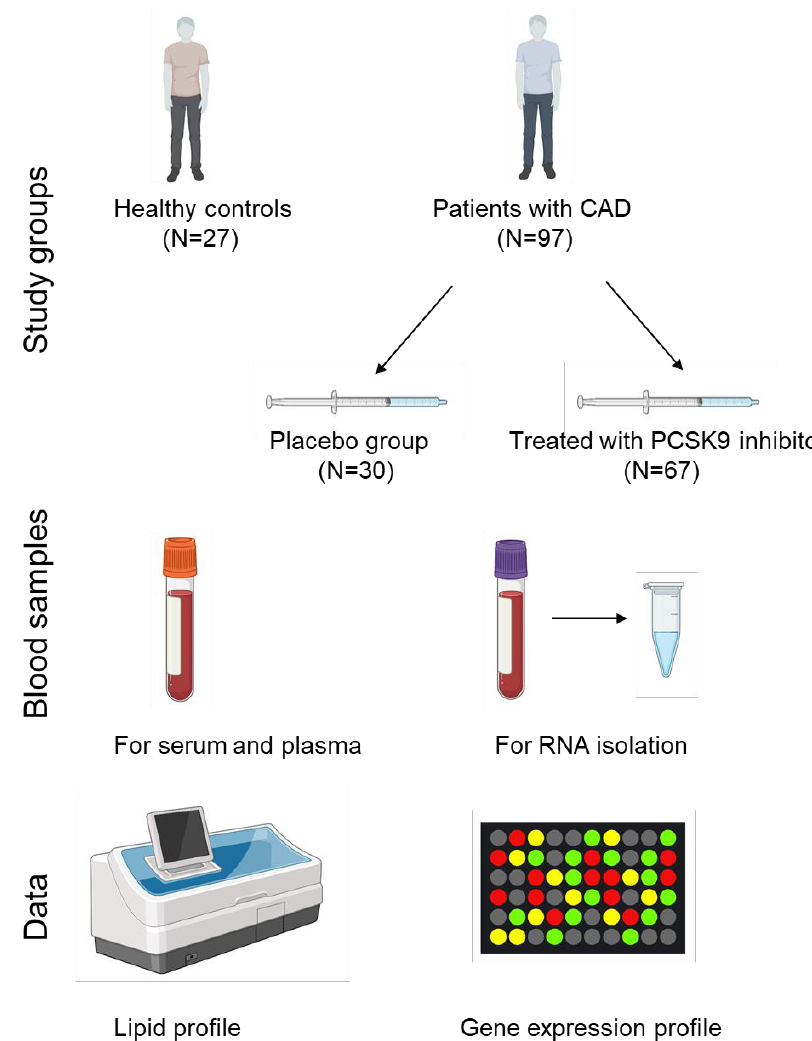
Figure 1. The study design. Subjects included in the study were healthy adults with no history of CAD and patients with CAD. Patients with CAD were randomized to the placebo group and the group treated with PCSK9 inhibitors, i.e., alirocumab (150 mg, N = 34 patients) or evolocumab (140 mg, N = 33 patients) for six months. Blood samples were taken at a single point for healthy controls and at the baseline and after six months of treatment for CAD patients. The lipid profile was measured and gene expression for the five studied genes ( IL1B , IFNG , VEGFA , F3 , SERPINE ), and two reference genes ( GAPDH and RPL13A ) was